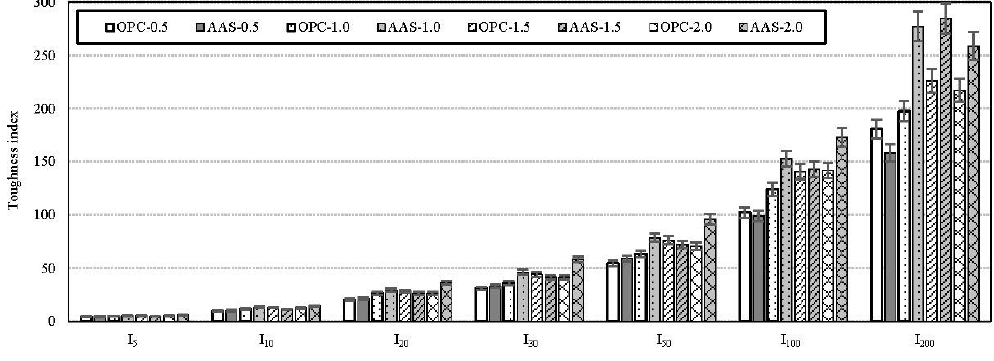
Figure 7. Comparison of toughness indices.